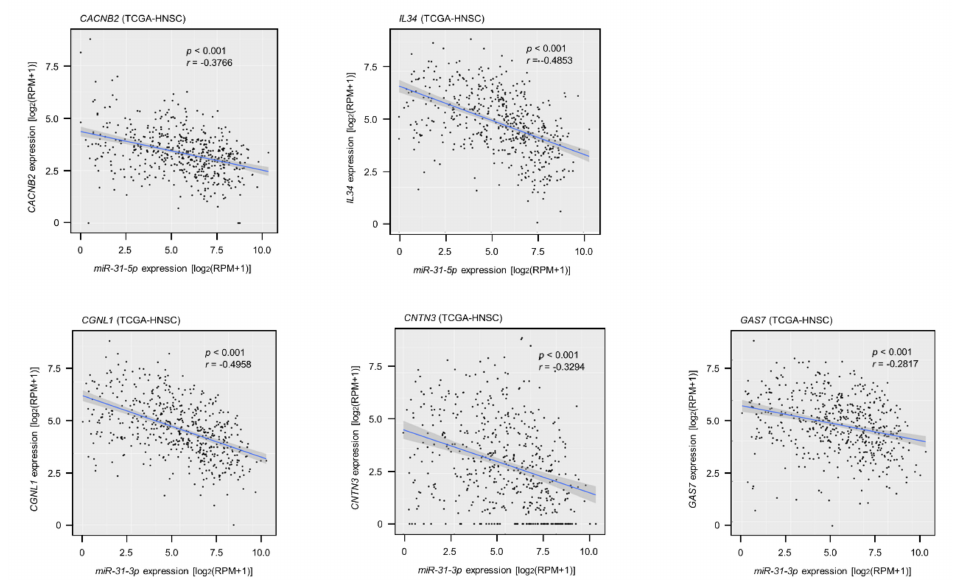
Figure 7. Expression correlation between miR-31 and their target genes in HNSCC clinical specimens. Spearman’s rank test indicated negative correlations of miR-31-5p expression with their targets ( CACNB2 / miR-31-5p : p < 0.001, r = − 0.3748; IL34 / miR-31-5p : p < 0.001, r = − 0.5296). Similarly, negative correlations were detected in miR-31-3p expression with their targets ( CGNL1 / miR-31- 3p : p < 0.001, r = − 0.5145; CNTN3/miR-31-3p : p < 0.001, r = − 0.3601; GAS7 / miR-31-3p : p < 0.001, r = −